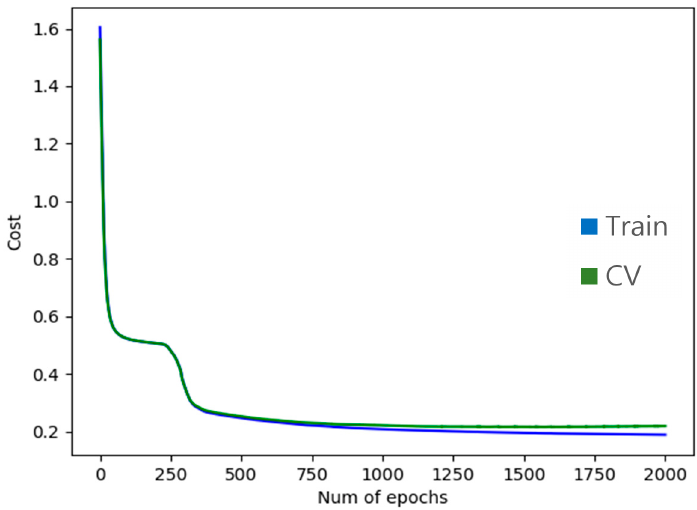
Figure 5. Graph of Training cost and Cross Validation (CV) cost according to learning rate.